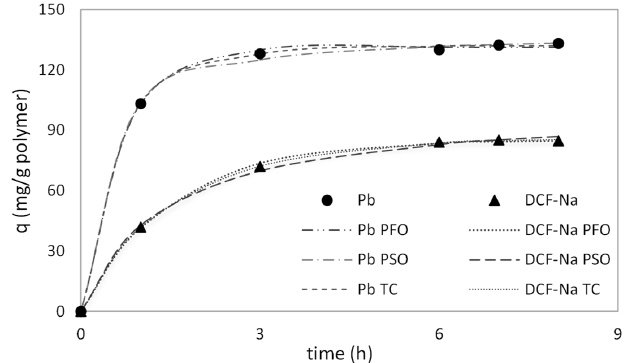
Figure 2. The influence of contact time on the sorption capacity of IS/(PEI/PMAA) c (r = 1.0) on the lead ions and diclofenac sodium from a bi-component mixture. Table 3. Kinetics parameters for Pb 2+ ions and DCF-Na simultaneous sorption on IS/(PEI/PMAA) c (r =